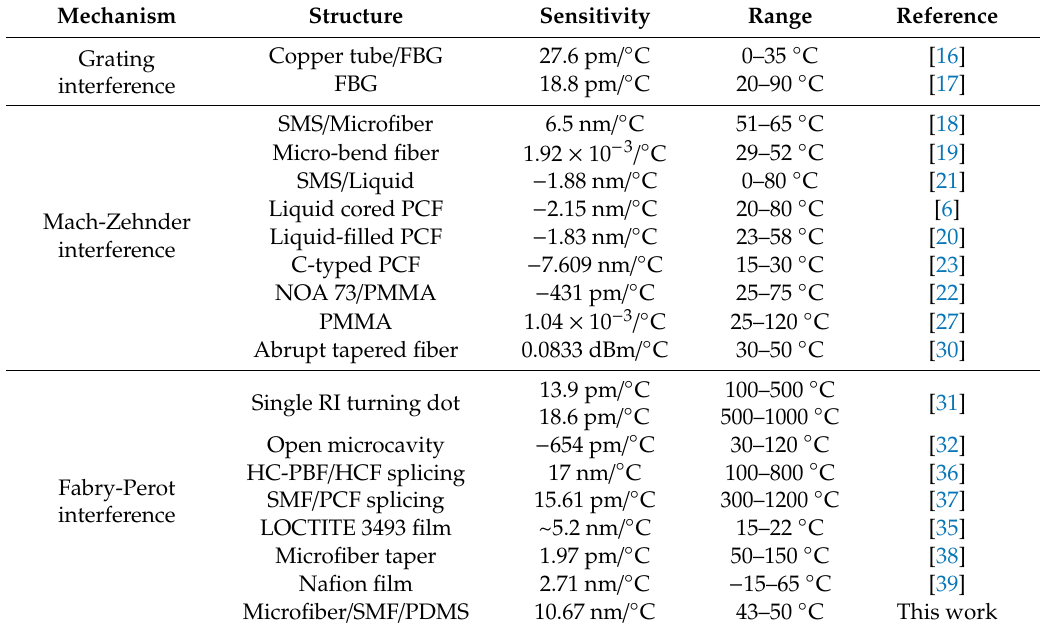
Table 1. Sensing performance comparison for typical temperature probes based on optical fibers.